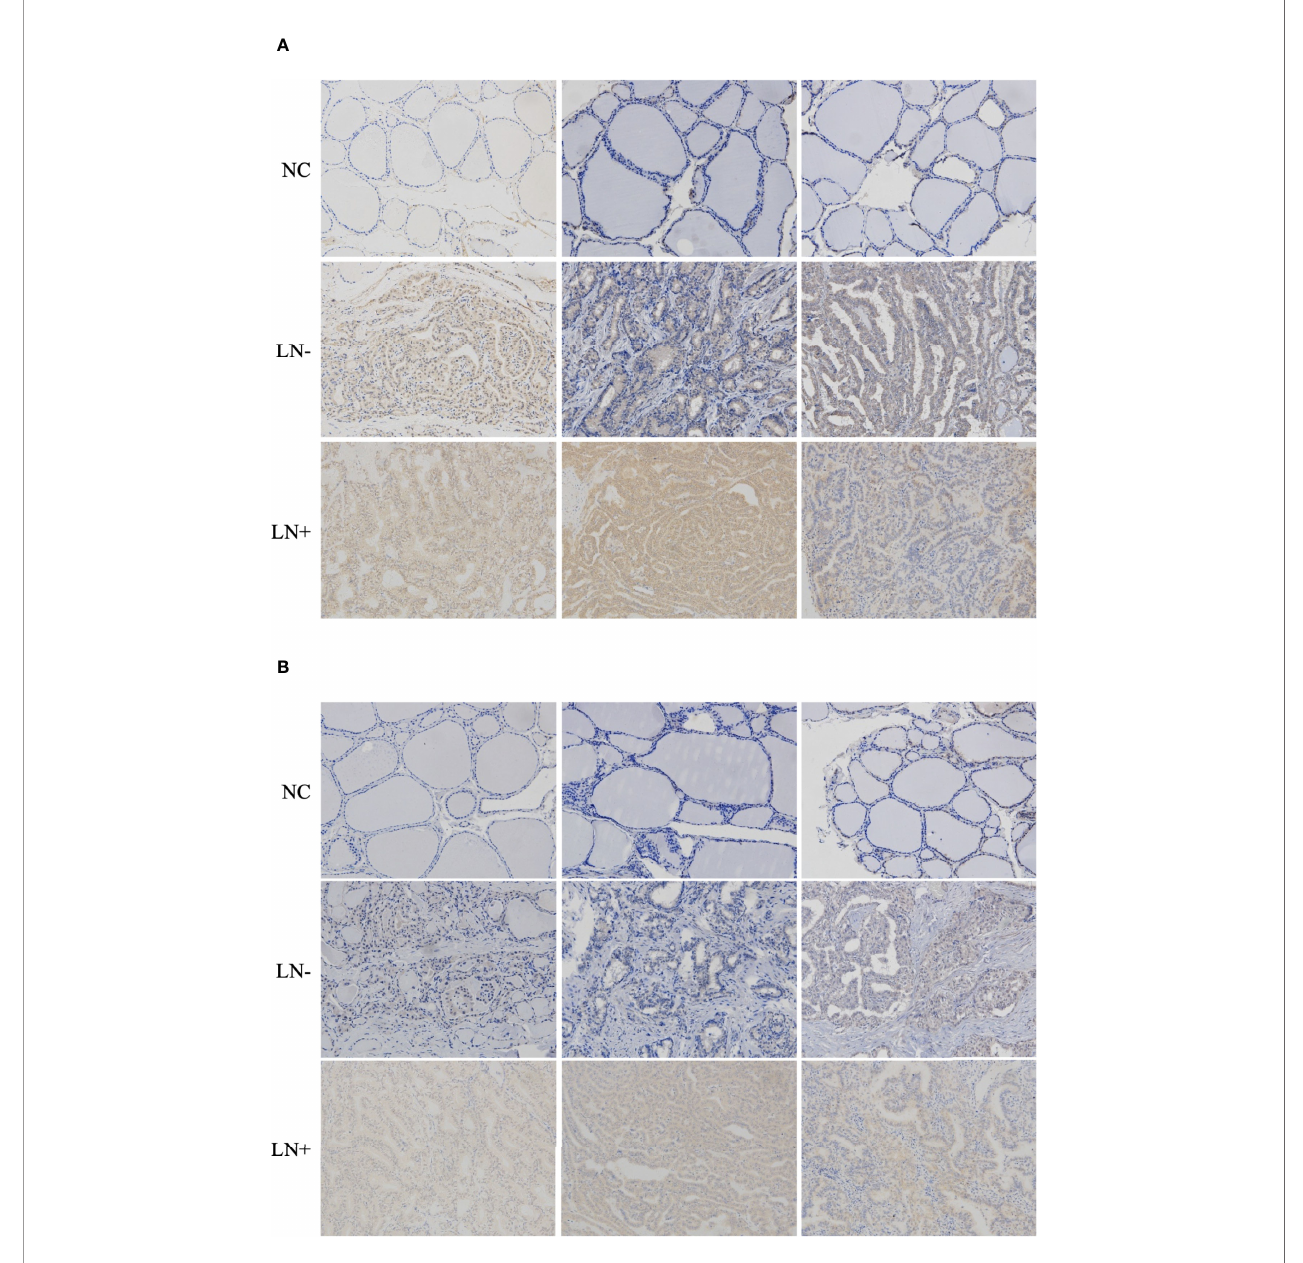
FIGURE 6 | Representative immunohistochemistry assay images of VEGF-C (A) and VEGFR3 (B) staining in thyroid normal tissues, PTC tissue without regional lymph node metastasis, and PTC tissue with lateral cervical lymph node metastasis. VEGF-C, vascular endothelial growth factor C; VEGFR-3, vascular endothelial growth factor receptor 3; PTC, papillary thyroid